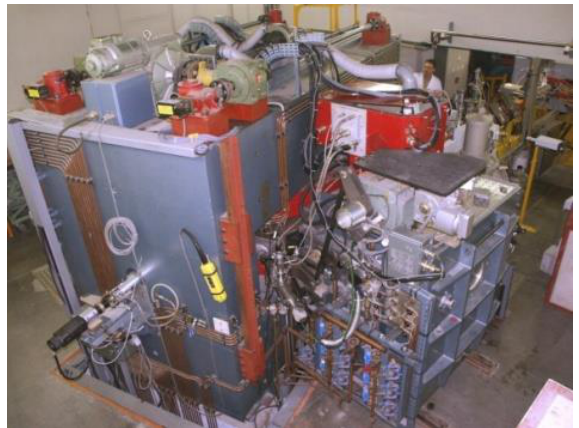
Figure 1. The cyclotron of Orléans.